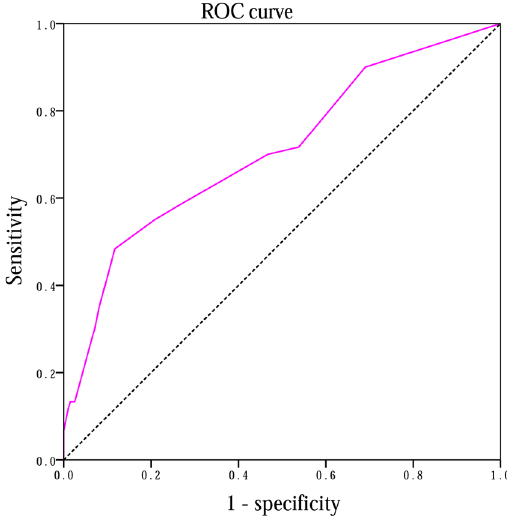
Figure 6. Discrimination capability of nomogram model. Receiver operating characteristic (ROC) curve showed an area under curve (AUC) of 0.708.